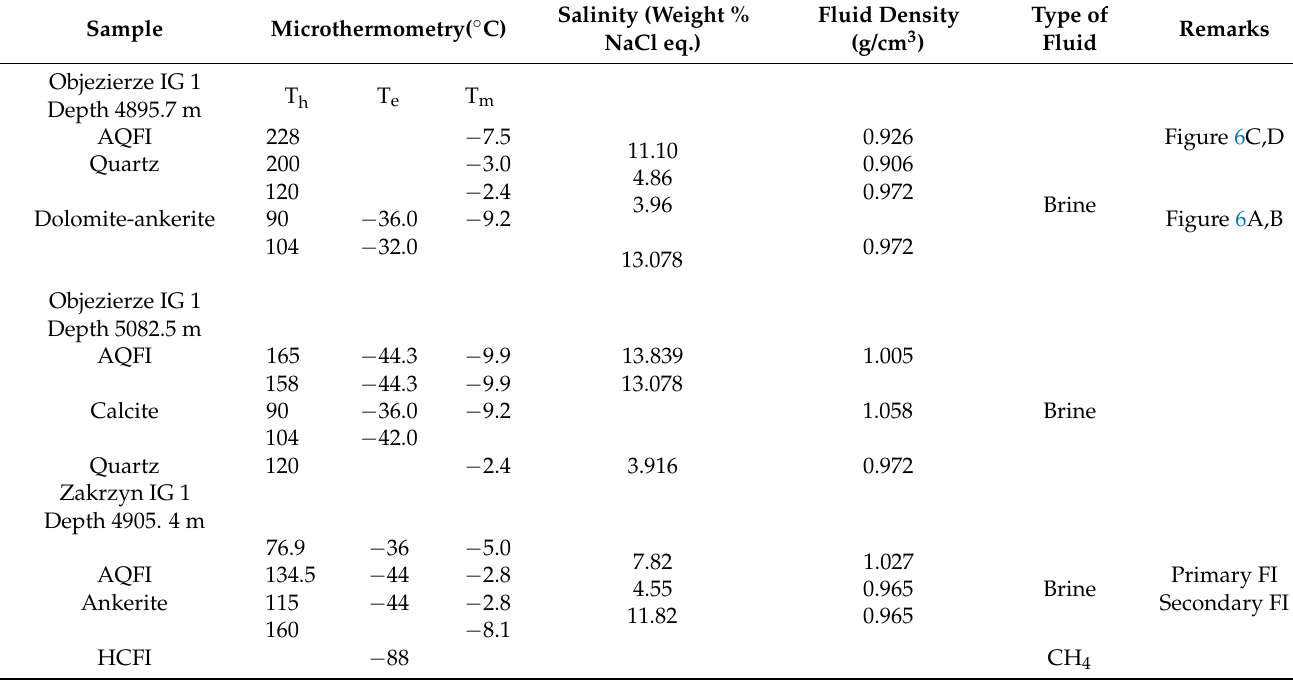
Table 4. Characteristics of fluids in fluid inclusions in the Objezierze IG 1 and Zakrzyn IG 1 boreholes *.